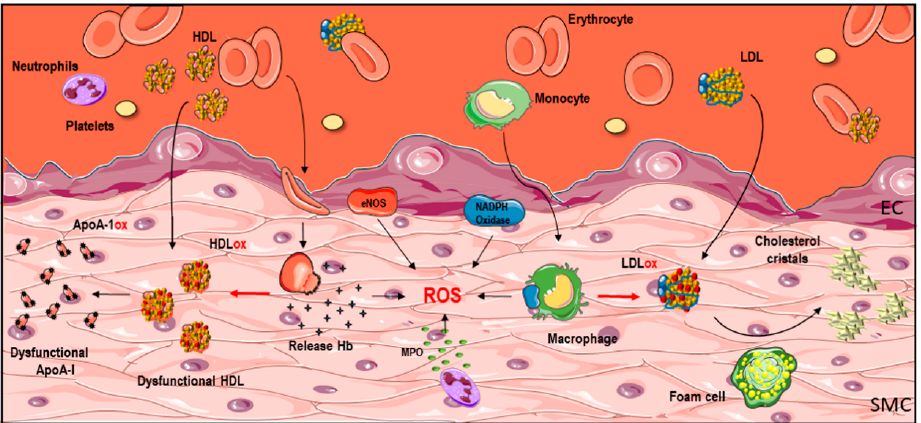
Figure 2. Sources of oxidative stress in the vascular wall. The oxidative process inside the pathological vascular wall is the result of the interaction of lipids/lipoproteins and reactive oxygen species (ROS) derived from infiltrating (red blood cells-RBC, platelets, leukocytes-neutrophils and monocytes) and resident (endothelial cells-EC- and smooth muscle cells-SMC-) cells. LDL, low-density lipoproteins; HDL, high-density lipoproteins; ApoA1, apolipoprotein A1; MPO, myeloperoxidase; Hb, hemoglobin; eNOS, endothelial NO synthase. Some graphical elements from this figure were adapted from Servier Medical Art Powerpoint image bank at http://smart.servier.com/.